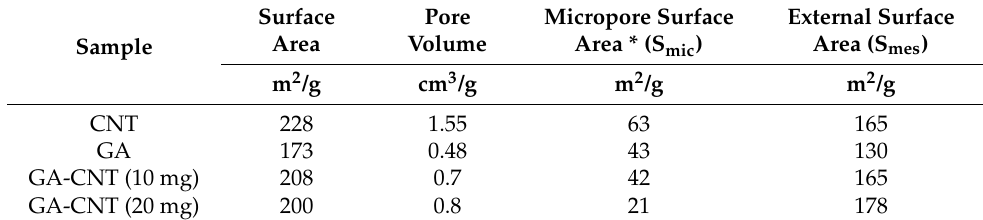
Figure 2. Characterisation by N 2 physisorption: ( a ) adsorption isotherms and ( b ) pore size distribution measured by BJH method applied to desorption isotherm. Table 2. Textural parameters of carbon nanotubes, graphene aerogels, and hybrids thereof.